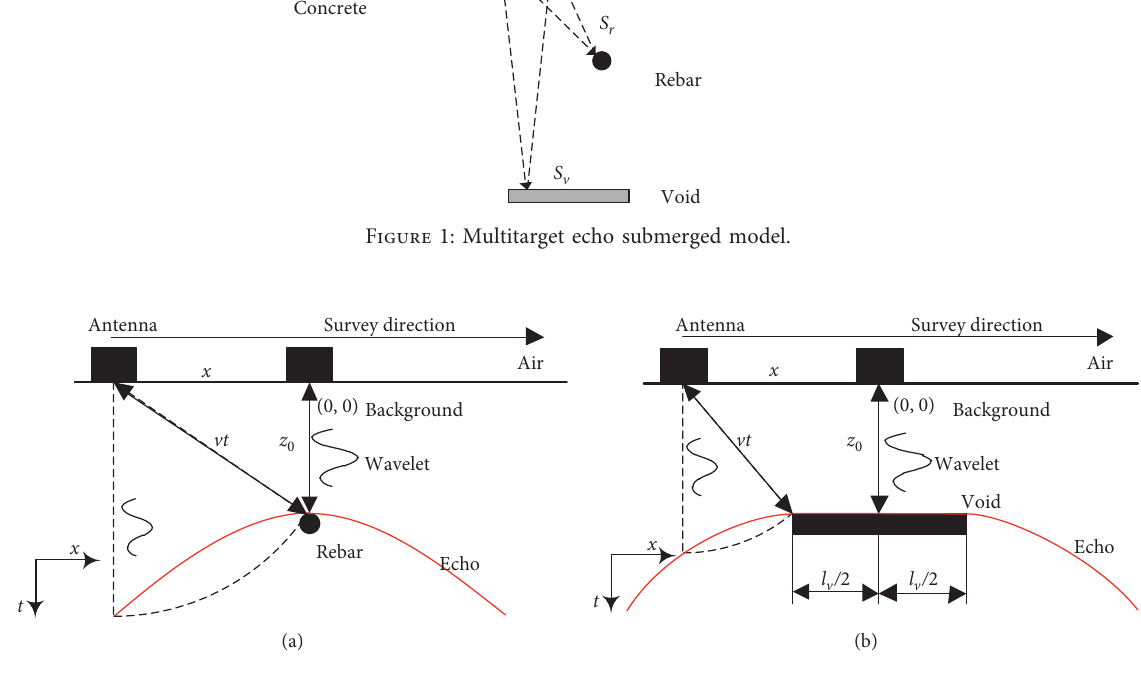
Figure 2: Rebar and void echo model: (a) rebar echo model; (b) void echo model.